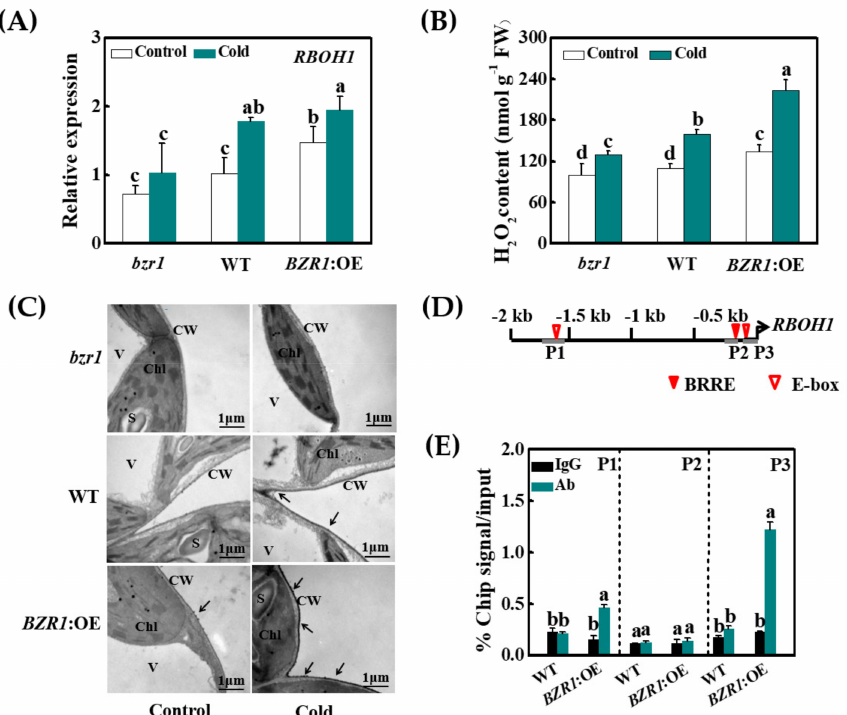
Figure 3. BZR1 functions as a transcription regulator for RBOH1 expression and positively regulates apoplastic H 2 O 2 . ( A ) The relative expression level of RBOH 1 , ( B ) accumulation of total H 2 O 2 , and ( C ) the apoplastic H 2 O 2 in bzr1 mutant, wild-type (WT), and BZR1 :OE plants under control (25 ◦ C) or cold (8 ◦ C) conditions. Black arrows indicate H 2 O 2 in the apoplast. Samples were collected at 8 h after cold treatment at 8 ◦ C. V, vacuole; S, starch grain; Chl, chloroplast; CW, cell wall. ( D ) BRRE and E-boxes in the tomato RBOH1 promoter sequence. Numbering is from predicted transcriptional start sites. ( E ) ChIP-qPCR analysis of BZR1 binding to the promoter fragments of RBOH1 in tomato. Input chromatin was isolated from leaves exposed to 8 ◦ C for 8 h. RBOH1 promoter fragments were immunoprecipitated with an anti-HA antibody. Mouse IgG was used in control reactions. Input- and ChIP-DNA samples were quantified by qRT-PCR. The ChIP data are shown as % input DNA. Data are the means of three biological replicates ( ± SD) shown by vertical error bars. Different letters indicate significant differences according to Tukey’s test at 0.05%